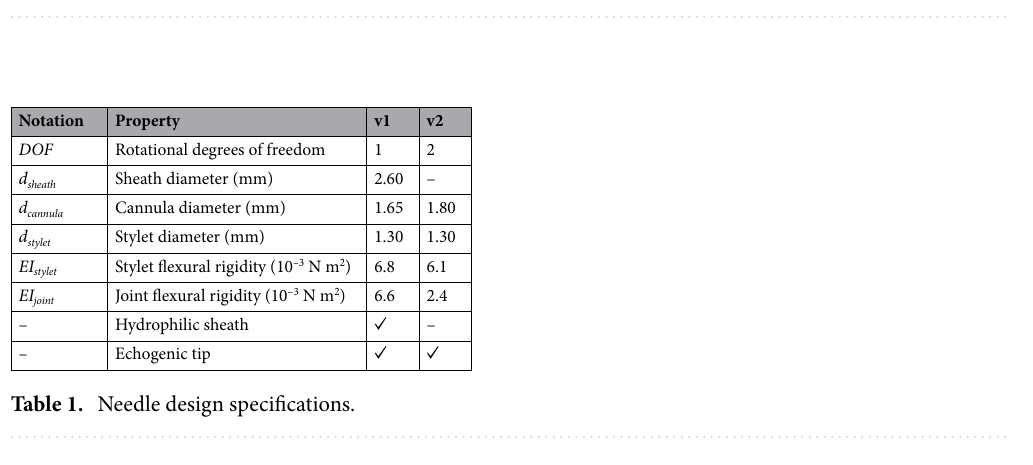
Steering mechanism. Figure 5 and Table 1 present an overview of v1 and v2 needle characteristics, includ- ing diameters and flexural rigidity values. Used parts and materials include nitinol stylets, nitinol concentric tubes or cannulas, and PTFE-coated nylon sheaths (6F Flexor Ansel Guiding Sheath, Cook Medical, USA). The